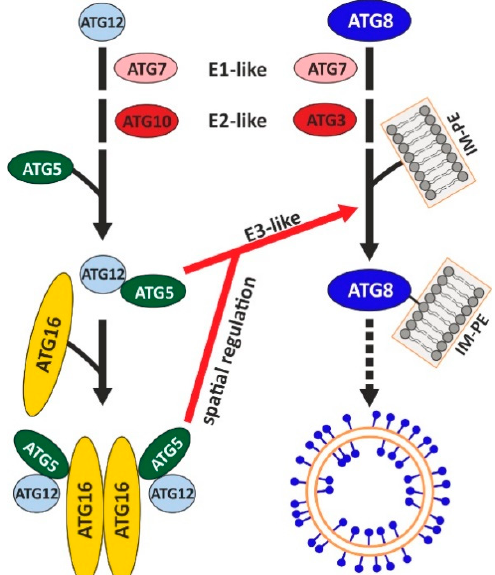
Figure 1. Schematic depiction of the components and their interrelations of the two ubiquitin-like conjugation systems in autophagy. The ATG12 (left) and the ATG8 (LC3 in mammals) (right) conjugation systems are represented. Similar to protein ubiquitination, the ubiquitin-like protein ATG12 is activated by the E1 enzyme ATG7 and transferred to the E2 enzyme ATG10. Finally, ATG12 is covalently attached to its target protein ATG5 and two ATG12~5 conjugates in turn associate non-covalently with an ATG16 dimer and form a heterohexameric complex. Likewise, the ubiquitin-like protein ATG8 is also activated by ATG7, transferred to the E2 enzyme ATG3, and finally conjugated to PE via an amide bond. The ATG12~5/16 complex catalyses via its E3-like activity the conjugation of ATG8 to PE at the isolation membrane. The different components of the two conjugation systems are not drawn to scale. IM-PE, isolation membrane containing phosphatidylethanolamine. Modified from [39]. See text for further details.